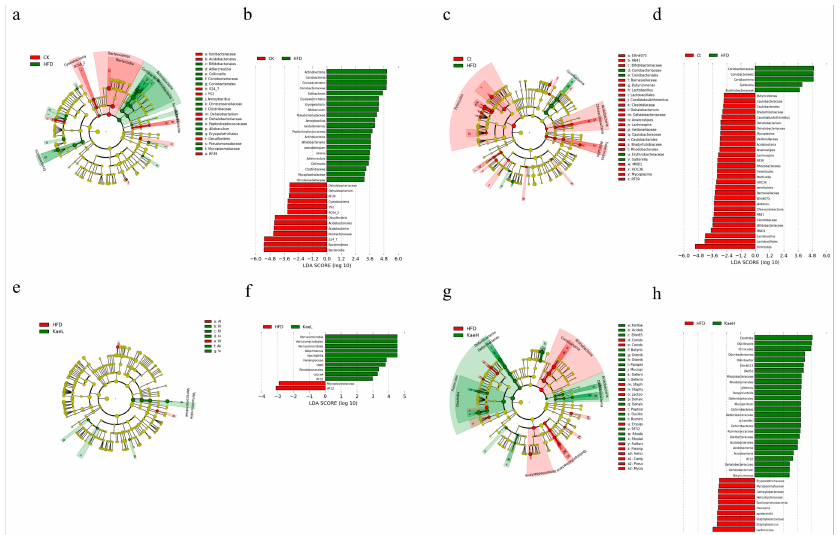
Figure 5. LEfSe cluster analysis of the structure of gut microbiome. Linear discriminant analysis effect size (LEfse) results are represented by circular cladograms ( a , c , e , g ). Differentially expressed